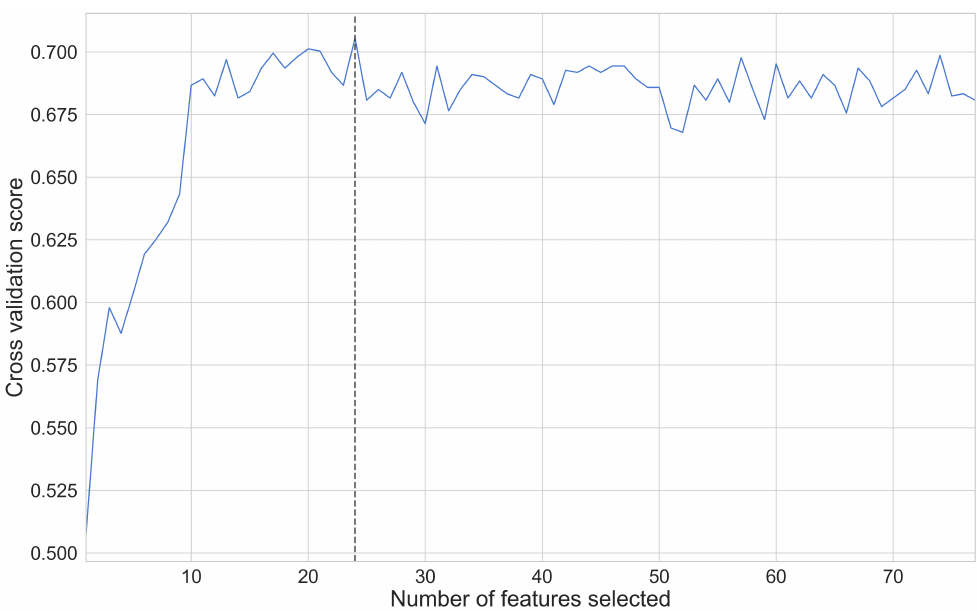
Figure 12. Assessing the number of important features through the use of the Recursive Feature Elimination and Cross-Validation (RFECV) algorithm. In this particular scenario, the optimal number of features was pruned down from a total of 77 to a mere